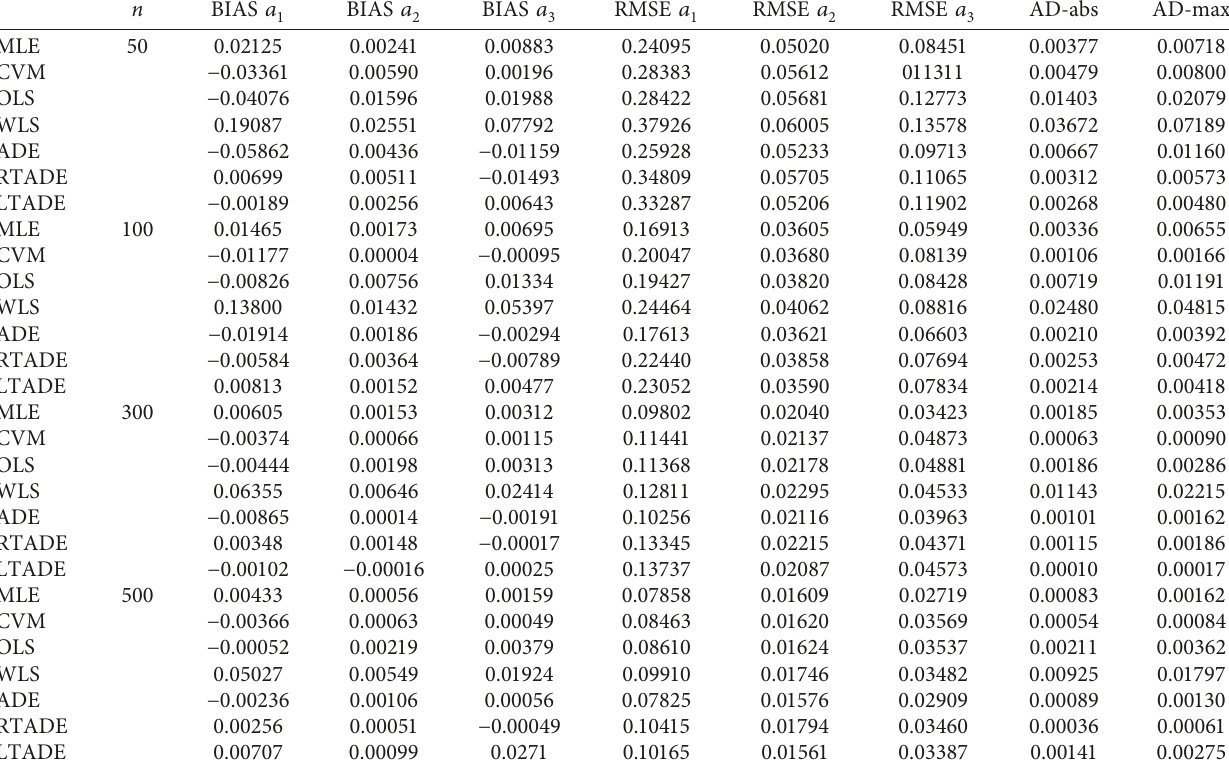
� 2.0, a � 0.6, and a 1 2